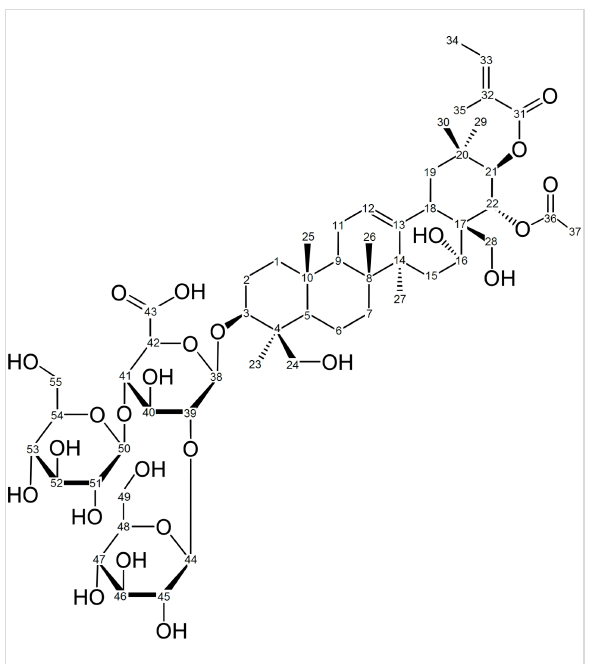
match with the geometry calculated for the complex γ 1 in the following section.